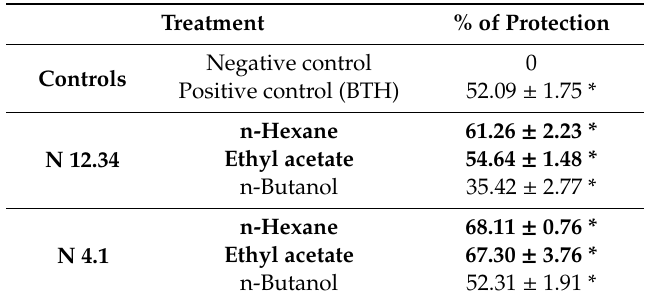
Table 4. Percentage of protection (%) induced in A. thaliana seedlings inoculated with the elicitor fractions against the pathogen P. syringae DC3000.